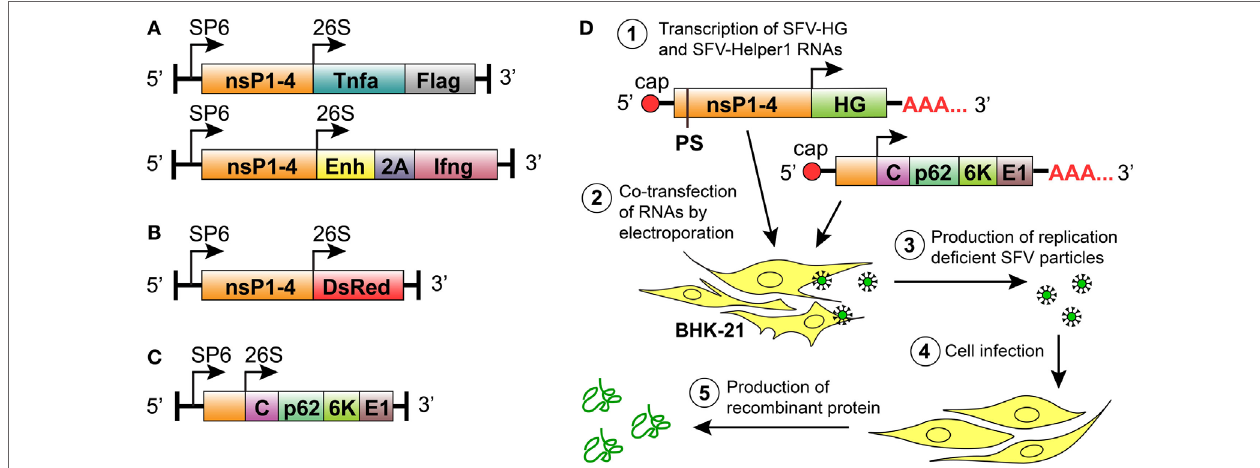
FigUre 1 | Semliki Forest virus (SFV) vectors used in this study for replication-deficient expression system. All vectors comprised the prokaryotic SP6 RNA polymerase promoter for in vitro transcription of the recombinant SFV replicons. (a) Replication-deficient vectors encoding SFV non-structural protein genes (nsP1–4) and the heterologous genes (HGs) Tnfa or Ifng downstream of the SFV 26S subgenomic promoter. The mouse TNF- α gene ( Tnfa ) was followed by a FLAG- tag-encoding sequence. The mouse IFN- γ gene ( Ifng ) was inserted in frame with the minimal capsid translation enhancer sequence ( Enh ) using the 2A auto- protease sequence ( 2A ) from foot and mouth disease virus as a linker. (B) Replication-deficient reporter construct consisting of SFV nsP1–4 and the fluorescent protein-encoding gene Ds-Red downstream of an SFV 26S subgenomic promoter. (c) The SFV helper vector SFV-Helper1, which encodes the full length of the structural protein ORF (i.e., C, capsid protein; p62, 6K and E1, and envelope proteins) downstream of an SFV 26S subgenomic promoter. (D) Production of recombinant particles and proteins by the replication-deficient SFV vector system: (1) in vitro transcription of RNA encoding the HG and the nsP1–4, and the transcription of helper RNA carrying SFV structural genes. The packaging signal (PS) for the selective encapsidation of the RNA encoding nsP1-4 and the HG is present in the nsP2 region of SFV-HG RNA. Both RNAs are capped at the 5-prime end and polyadenylated at the 3-prime end; (2) BHK-21 cells are transfected with SFV-HG and SFV-Helper RNAs by electroporation; (3) BHK-21 cells produce replication-deficient SFV particles carrying HGs; (4) target cells are infected with replication-deficient SFV particles; and (5) the heterologous protein is produced at high levels without production of new viral